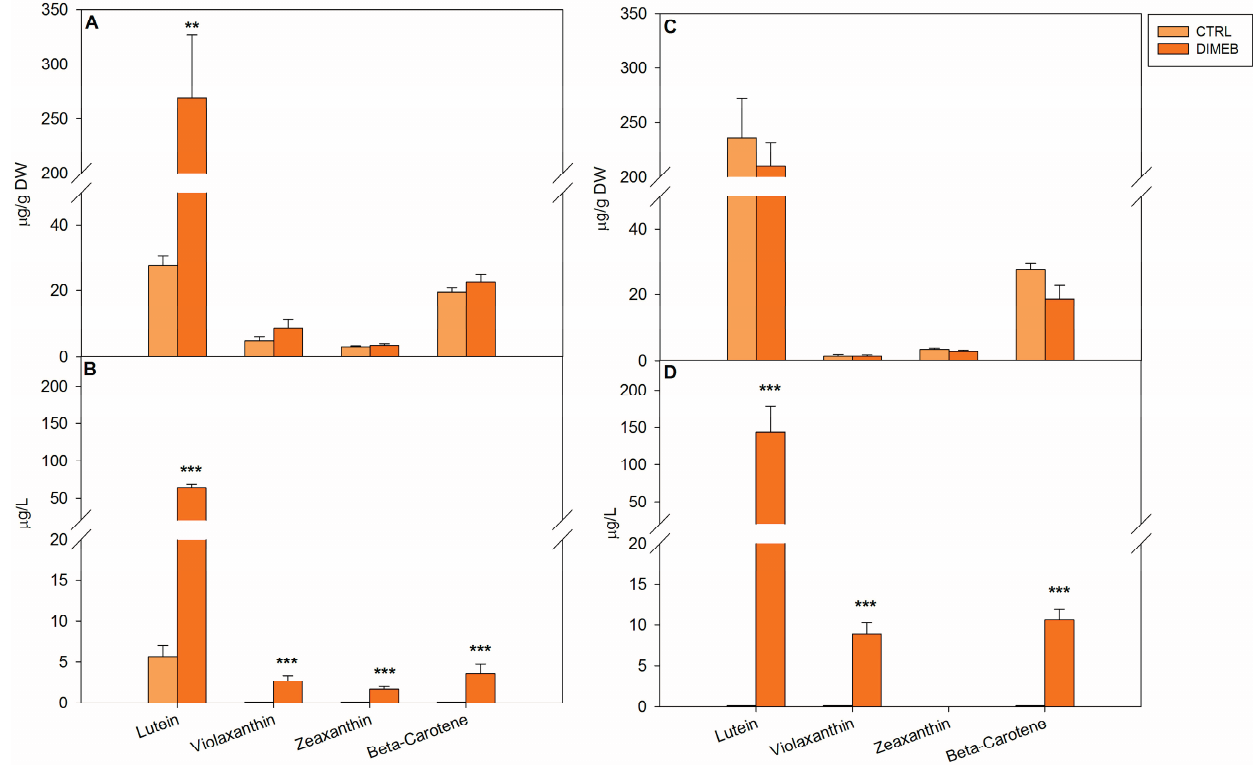
Figure 1. Intracellular and extracellular carotenoid levels in A. annua cell cultures untreated (CTRL) or treated (DIMEB) with 50 mM DIMEB. Data are expressed as mean ± standard deviation from three independent experiments, ** p < 0.01; *** p < 0.001 in comparison with control assessed by Anova-one-way post hoc Holm-Sidak